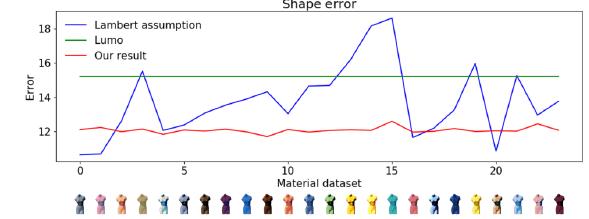
Fig. 14 Errors of estimated shape depending on input material (medium complexity shape Venus ).